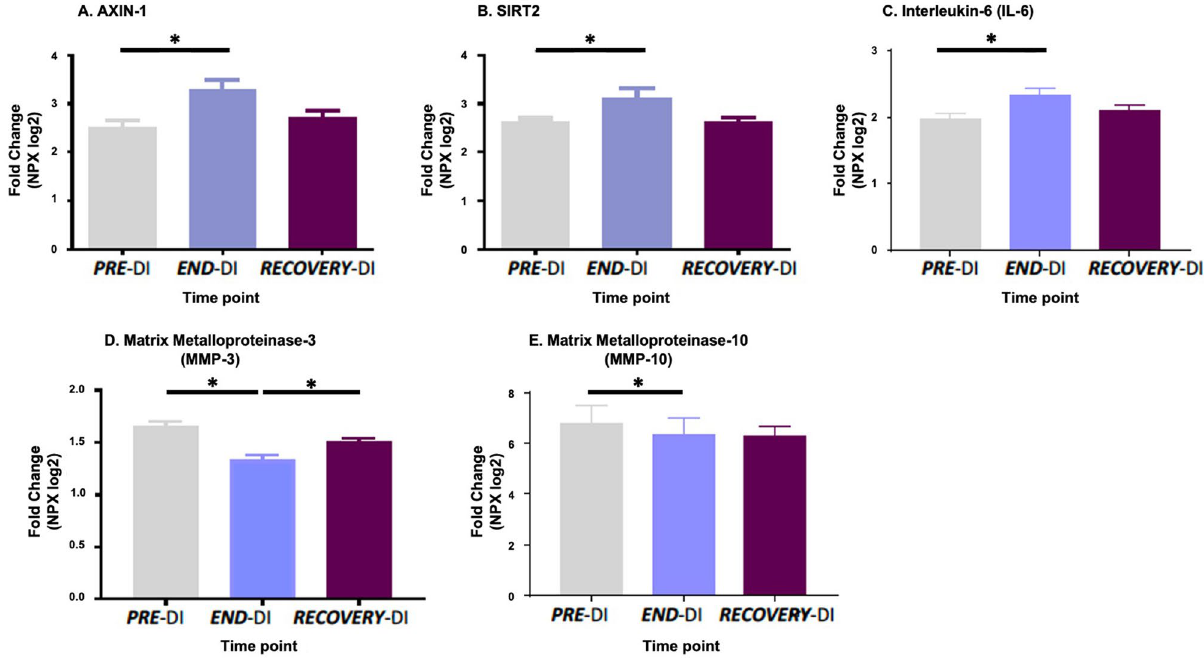
Figure 5. Effect of dry immersion on inflammatory protein biomarkers. All data are expressed mean ± SEM. ( A ) Axin1, ( B ) SIRT2, ( C ) Interleukin-6, ( D ) Matrix metalloproteinase-3 and ( E ) Matrix metalloproteinase 10. Axin1 and MMP-3 were specific to INF panel while Il-6, SIRT2 and MMP-10 were also found on the CVD panel. * P < 0.05, Paired samples t-test and repeated measures ANOVA (adjusted for age, BMI and VO 2 ; n = 12 biological